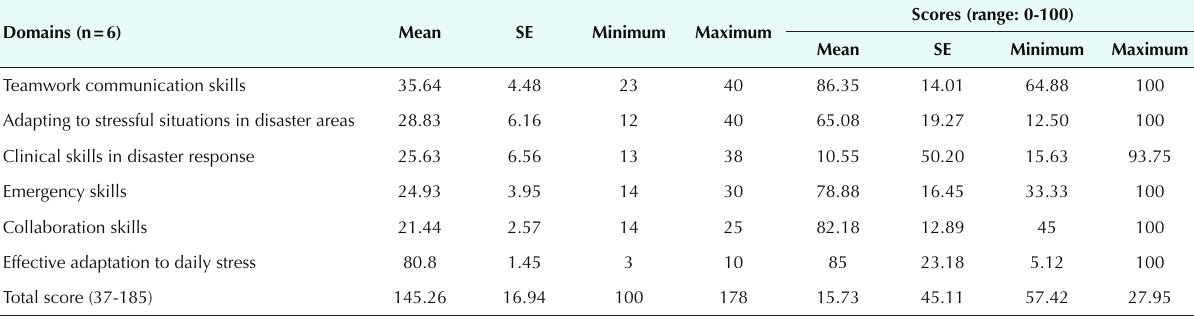
Scores (range: 0-100)